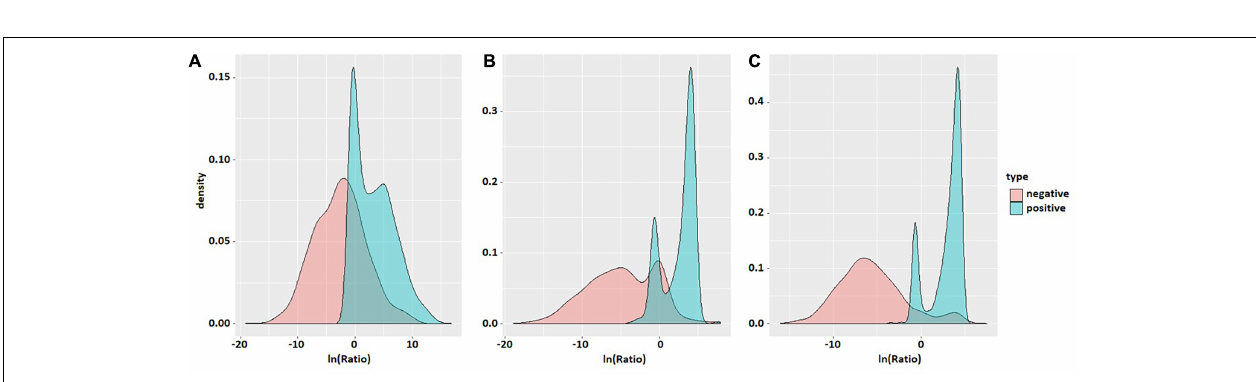
Frontiers in Genetics |